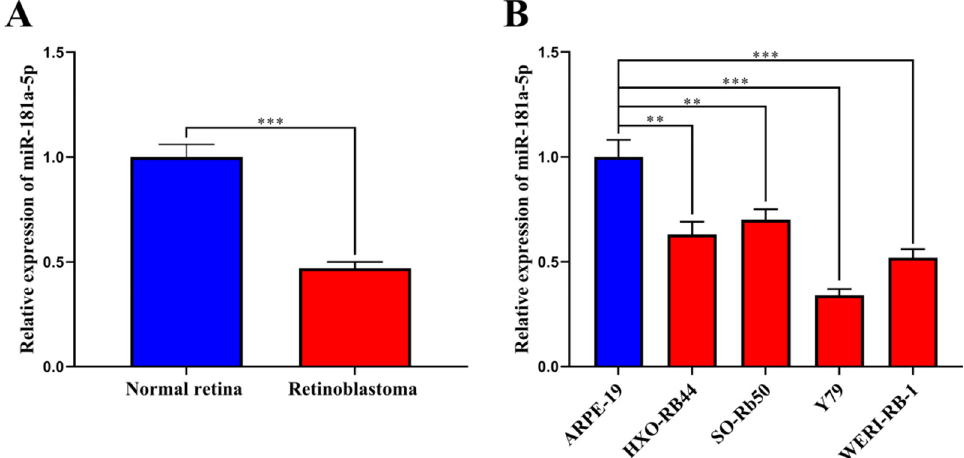
Fig. 2. MiR-181a-5p is downregulated in RB tissues and cell lines. (A) Quantitative reverse Transcription-Polymerase Chain Reaction (qRT-PCR) showed that miR- 181a-5p was signi fi cantly downregulated in RB tissues compared with the normal retinal tissues. (B) qRT-PCR showed that miR-181a-5p was signi fi cantly downregu- lated in RB cell lines compared to the normal retinal pigment epithelial cells. The expression of miR-181a-5p was normalized to that of the U6 small nuclear RNA (snRNA). The data are shown as the mean ± standard deviation from three independent experiments. **p < 0.01 and ***p < 0.001.